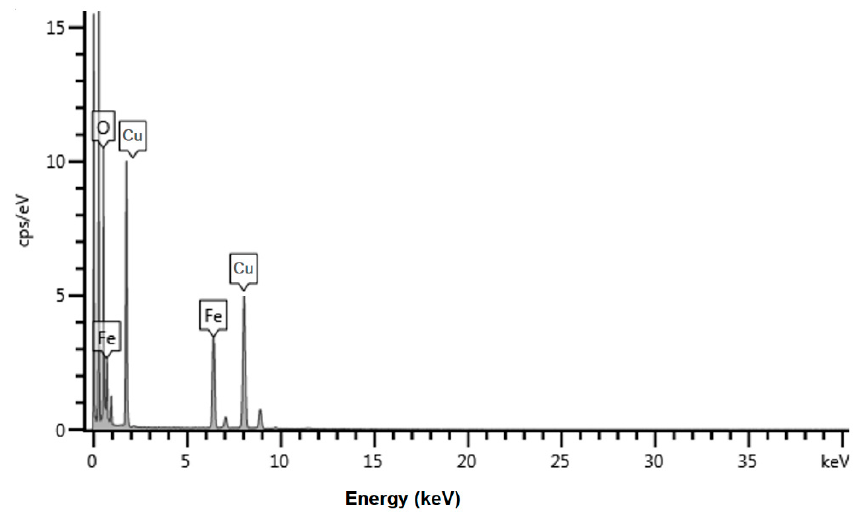
Figure 5. EDS pattern of the synthesized A-IONPs.